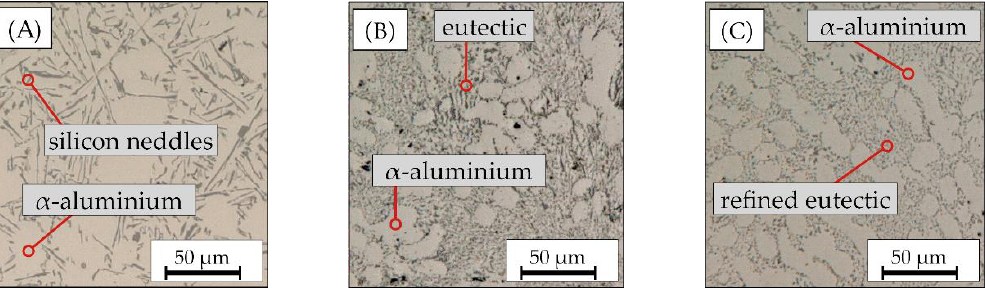
Figure 1. Al-Si casting alloy system; ( A ) non-refined; ( B ) refined; ( C ) homogenisation annealed by 380 °C and 4 h, authors own figure. Represents an extension to the figure in Neuser et al. [17].